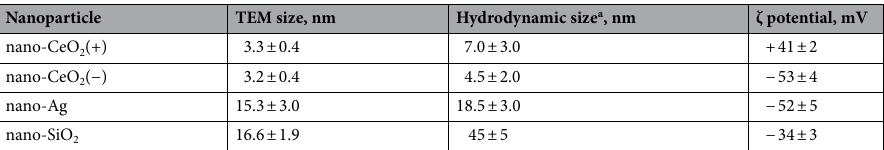
Table 1. Key characteristics of nanoparticles used. a Number based hydrodynamic size according to DLS (dynamic light scattering)